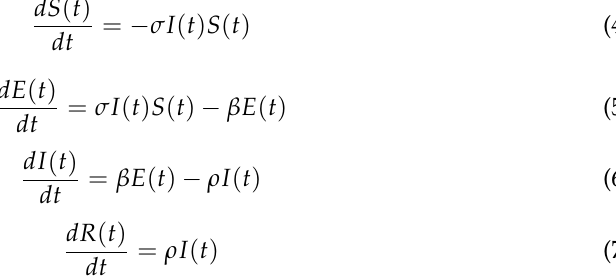
Figure 2. SEIR model flow chart .